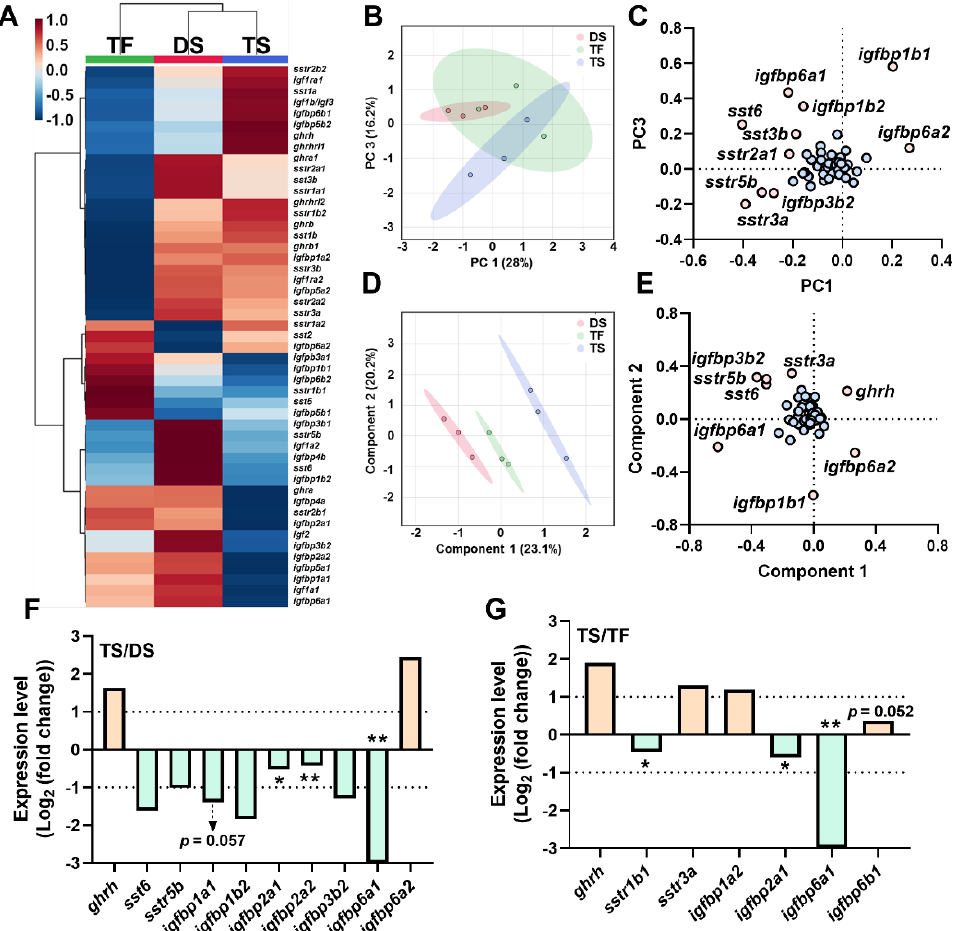
Figure 3. The transcriptional signature of ghrh-sst-gh-igf axis in brain in diploid and triploid trout. ( A ) The heatmap of ghrh-sst-gh-igf axis in brain. ( B , C ) Principal component analysis ( B ) and loading plot ( C ) of ghrh-sst-gh-igf axis. ( D , E ) Partial least squares discriminant analysis ( D ) and loading plot ( E ) of ghrh-sst-gh-igf axis. In loading plot, gene(s) further away from center point (0, 0) showed obvious effects on principal component analysis/partial least squares-discriminant analysis. ( F , G ) Key genes of ghrh-sst-gh-igf axis of TS/DS ( F ) and TS/TF ( G ). Genes were selected based on the principle of Log 2 |Foldchange| ≥ 1 or p value < 0.05 (Log 10 (count+1) by Student’s t -test, “*” p < 0.05; “**” p < 0.01). TS: t riploid s eawater exposure; DS: d iploid s eawater exposure group; TF: t riploid f reshwater exposure group.